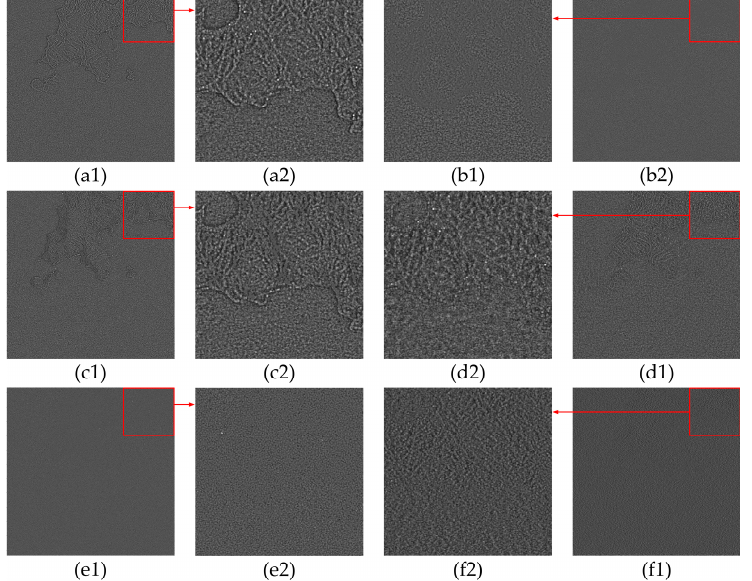
Figure 9. Ratio images by noisy Sentinel-1 SAR image and the ( a1 ) SRAD, ( b1 ) DPAD, ( c1 ) EnLee, ( d1 ) PPB, ( e1 ) SAR-BM3-D, and ( f1 ) FANS filtered images. ( a2 – f2 ) are the enlarged images of the red rectangle from ( a1 – f1 ).